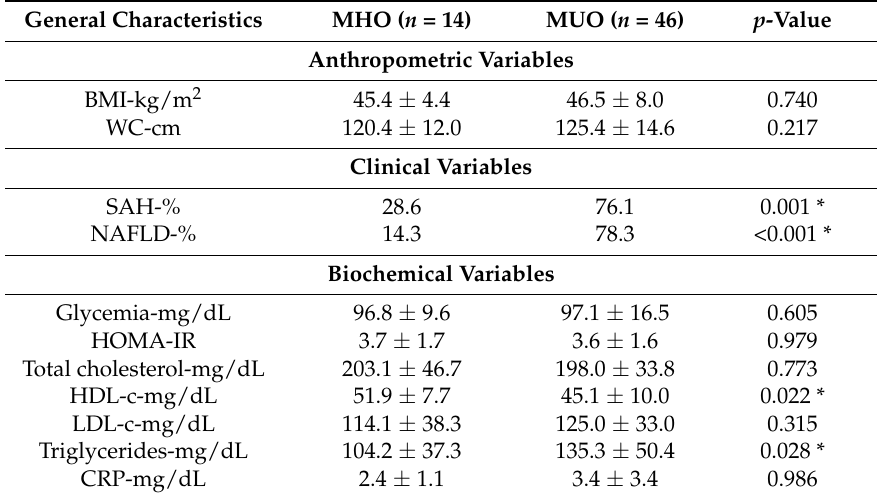
Table 1. Anthropometric, clinical and biochemical variables in adolescents classified as having metabolically healthy or unhealthy obesity.